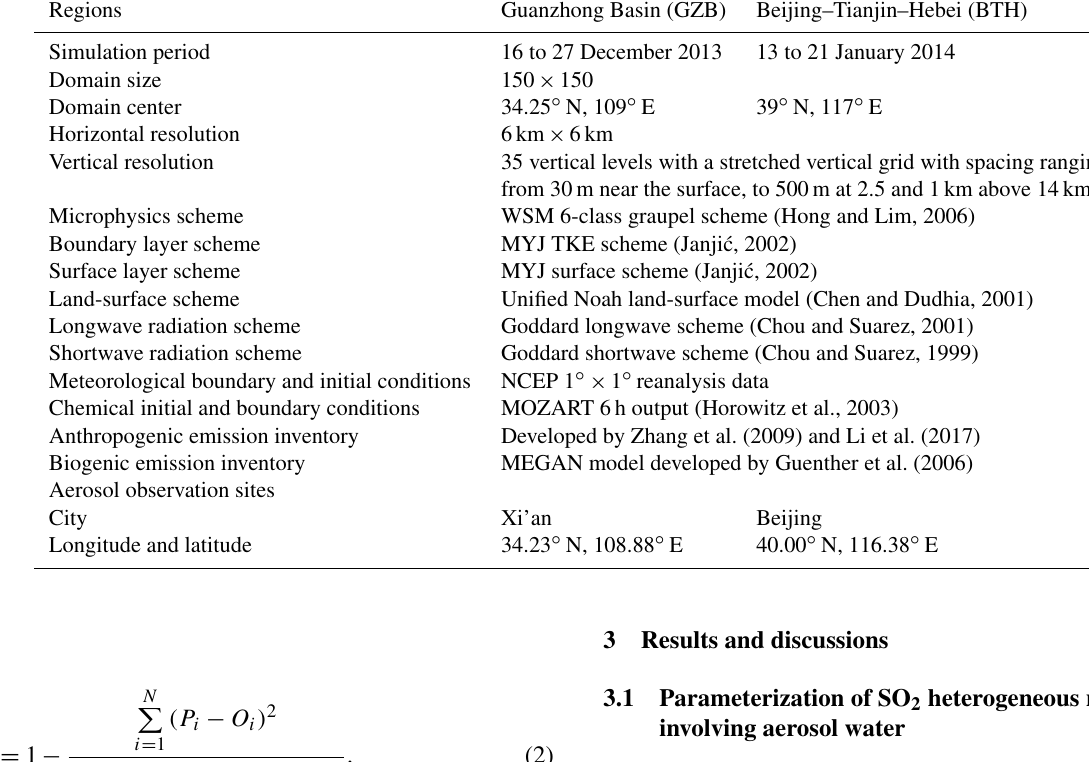
Table 1. WRF-CHEM model configurations and observation sites.